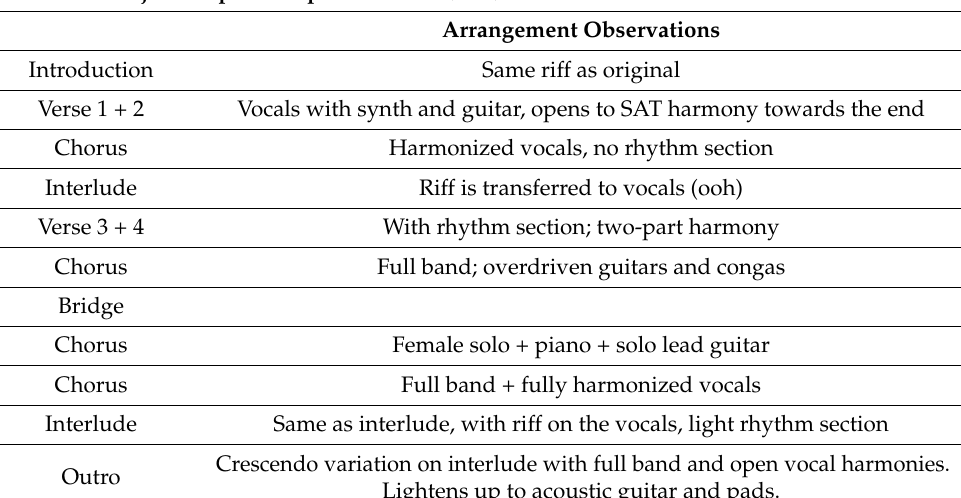
Table 7. Form and arrangement outline of Uni ã o Coral’s version of “Poder pra salvar”. Uniao Coral